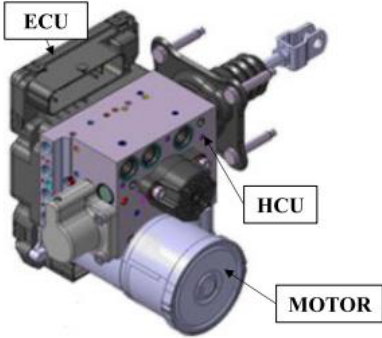
Figure 1. Integrated electric brake system.